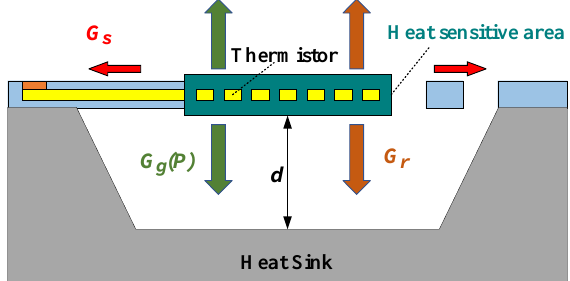
Figure 1. Thermal conductivity mechanism of the Pirani gauge.